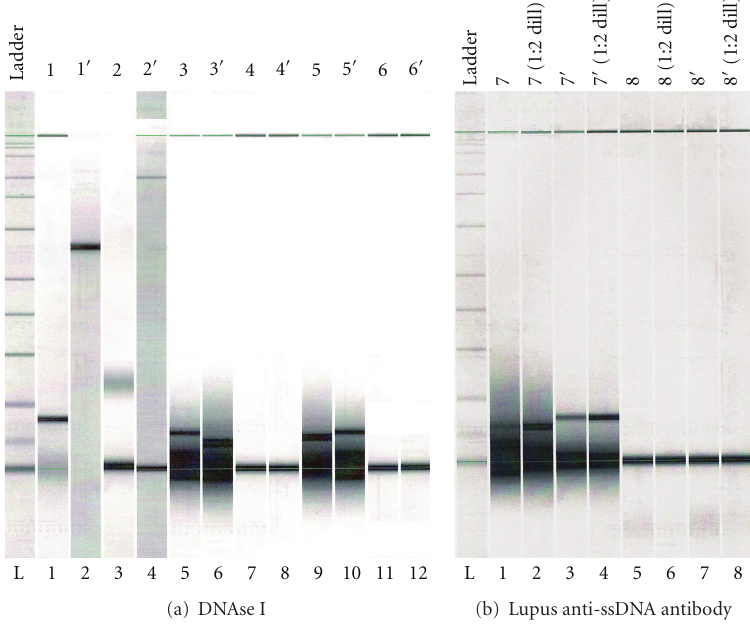
Figure 3: Detection of hydrolysis of ss herring sperm DNA by Agilent 2100 Bioanalyzer (DNA7500 microchip) digital analysis. ∗ Agilent 2100 Lab-on-Chip digital analysis comparison of hydrolysis of ss herring sperm DNA (obtained by heating and fast cooling) by DNAse I control and anti-poly-(dT) ssDNA antibody sample purified from lupus patient serum demonstrates that lupus anti-poly-(dT) ssDNA antibody is hydrolytic. (a) Lane 1: ss herring sperm DNA with DNAse I at T = 0. Lane 2: ss herring sperm DNA, no DNAse I. Lane 3: ss herring sperm DNA with DNAse I at T = 5min. Lane 4: lambda phage, no DNAse I. Lanes 5, 6: ss herring sperm DNA with DNAse I at T = 30min. Lane 7: lambda phage with DNAse I at T = 30 min. Lanes 8: lambda phage, no DNAse I. Lanes 9, 10: same as 5, 6. Lanes 11, 12: DNAse I, no substrate. (b) Lanes 1–4: ss herring sperm DNA with lupus anti-ssDNA antibody at T = 3hrs. Lanes 5–8: lambda phage DNA, no antibody.